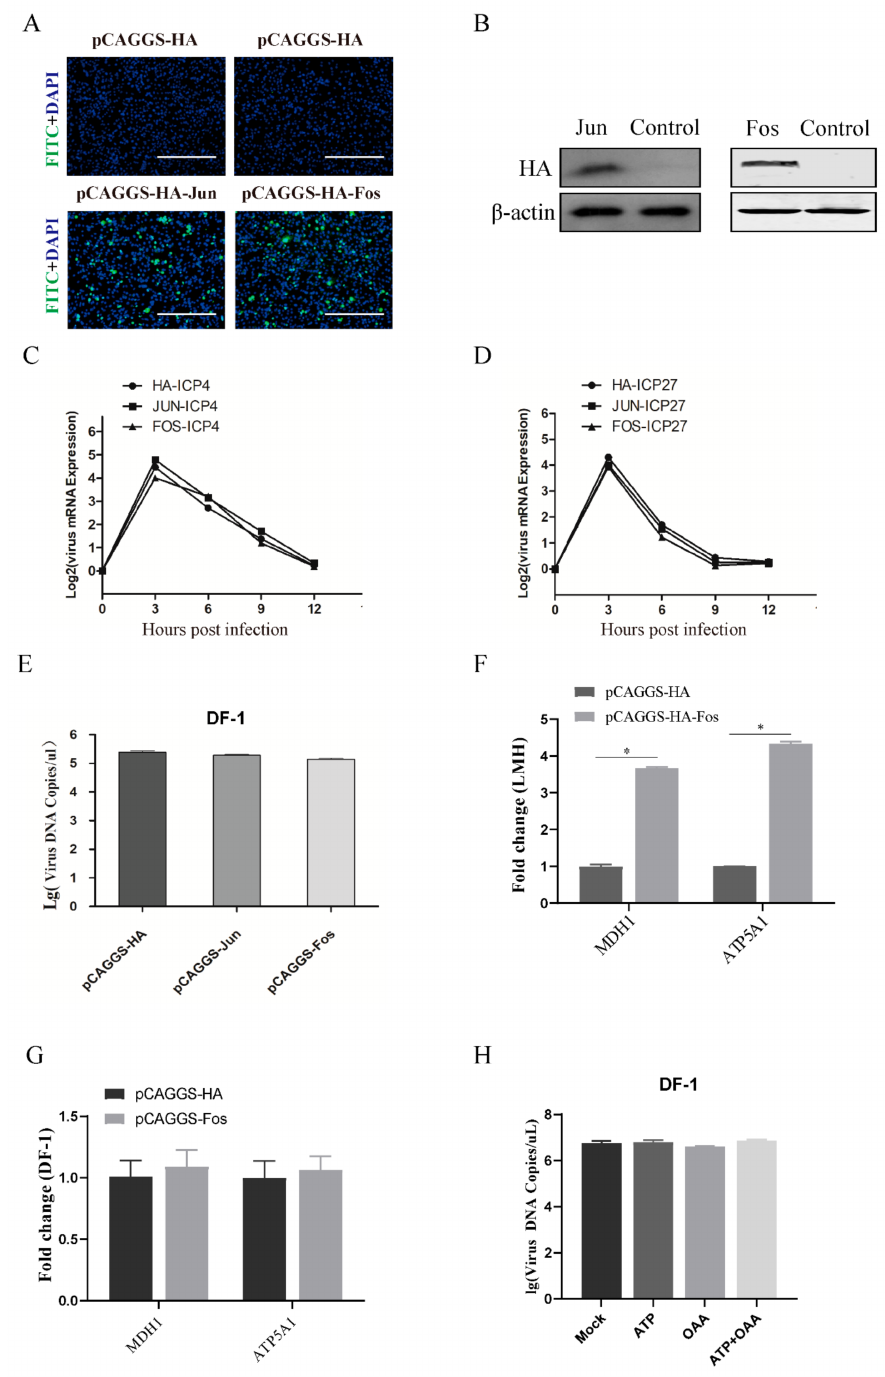
Figure 4. Effect of Fos/Jun overexpression on ILTV replication in DF-1 cells. DF-1 cells were transiently transfected with the pCAGGS-HA-Fos, pCAGGS-HA-Jun or pCAGGS-HA plasmid for 24 h. ( A ) Indirect immunofluorescence microscopy analysis of Fos and Jun overexpression using a mouse anti-HA antibody followed by a FITC-conjugated goat anti-mouse IgG secondary antibody (green). Chromosomes were stained with DAPI (blue). Scale bars, 150 µ m. ( B ) The protein expression levels of Fos and Jun in DF-1 cells transiently transfected with the pCAGGS-HA-Fos, pCAGGS-HA- Jun or pCAGGS-HA plasmid were analyzed by Western blotting using antibodies specifically against HA (top) and β -actin (bottom). β -Actin was used as a loading control. ( C – E ) Twenty-fourhours